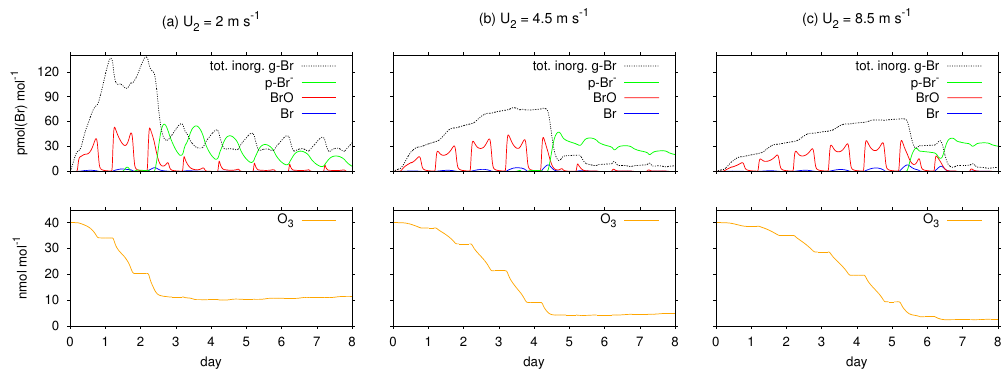
Fig. 2. Temporal evolution for the mixing ratios of inorganic bromine species (top row) and ozone (bottom row) at the height of 1.5 m in the ambient air from model runs employing scenario 1A at U 2 = 2 . 0ms − 1 (a) , 4.5ms − 1 (b) , and 8.5ms − 1 (c) . Total inorganic gaseous bromine in dotted black lines, particulate (or aerosol) bromide in green lines, BrO radical in red lines, Br-atom in blue lines and ozone in orange lines.